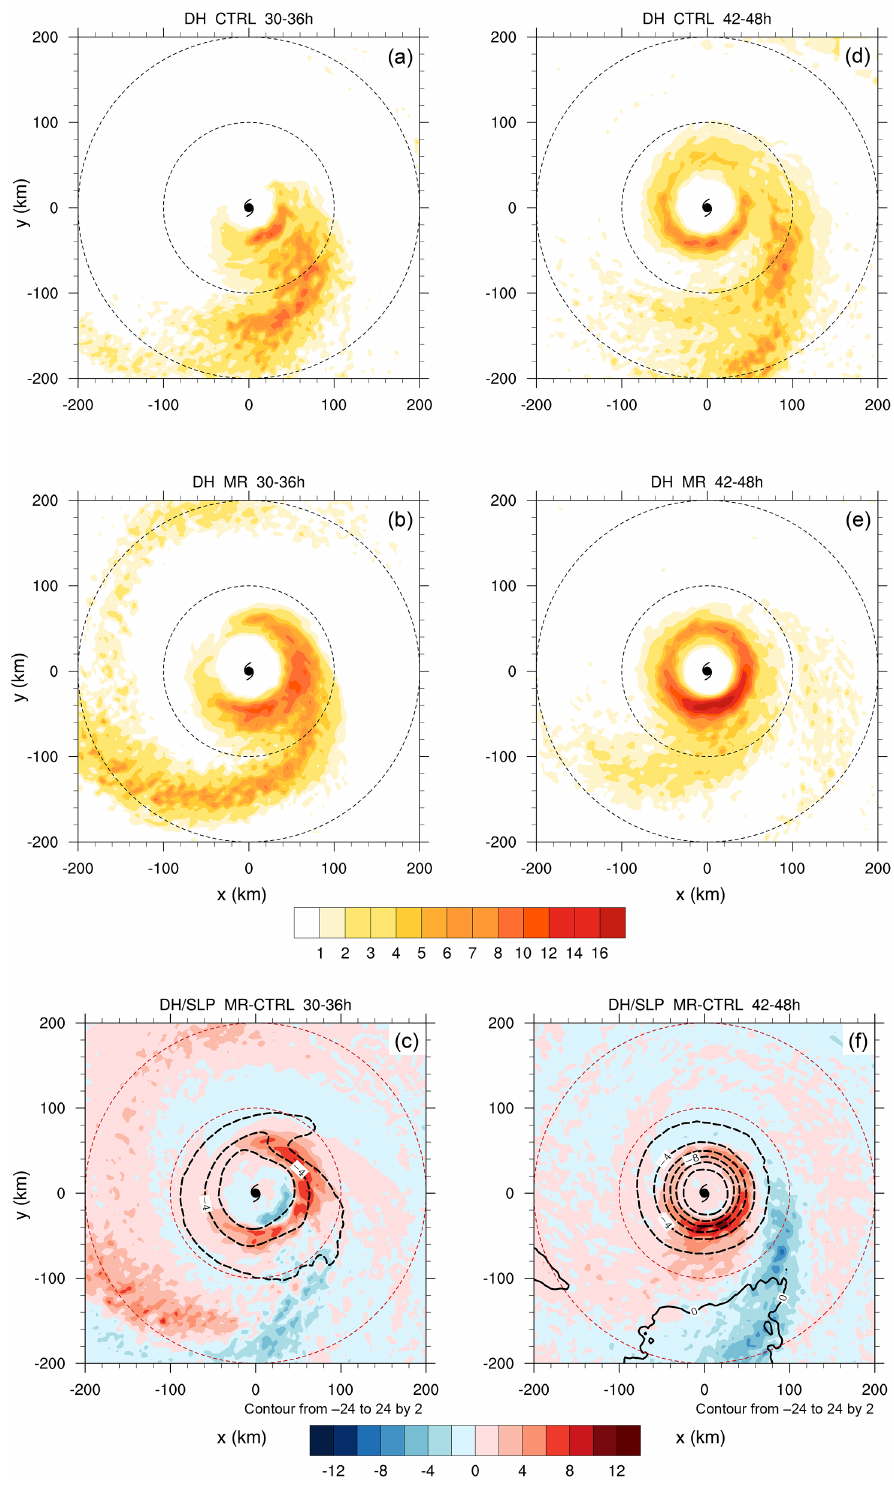
Figure 9. Same as Fig. 7 but for the MR and CTRL